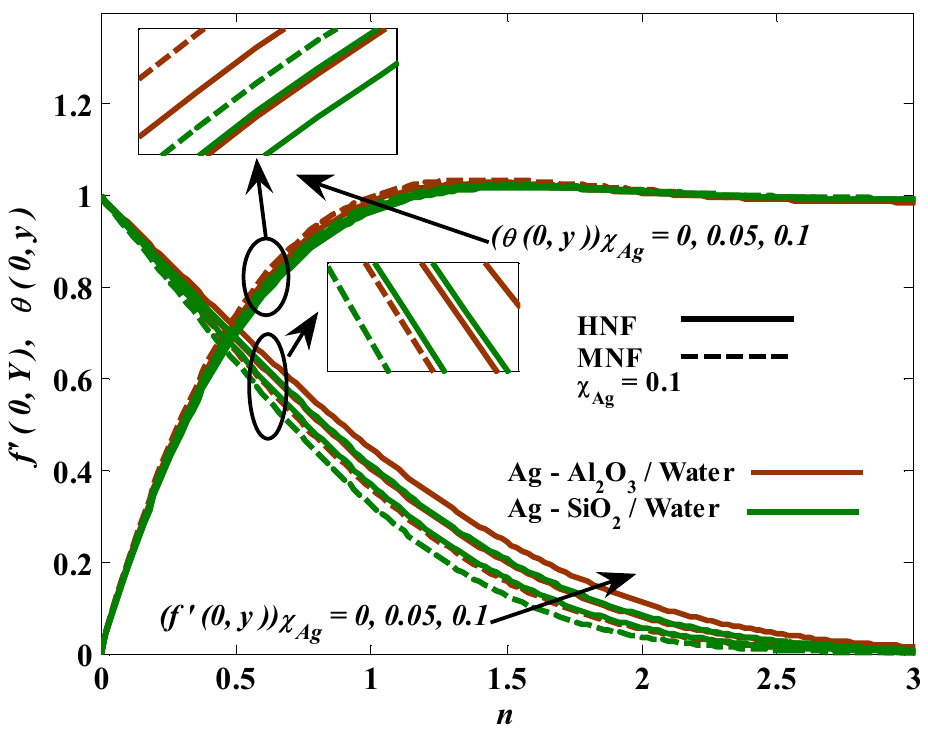
Figure 16. Illustration of χ versus temperature and velocity at fixed values of λ = 0.2, R = 0.1, M = 2 & We = 1.